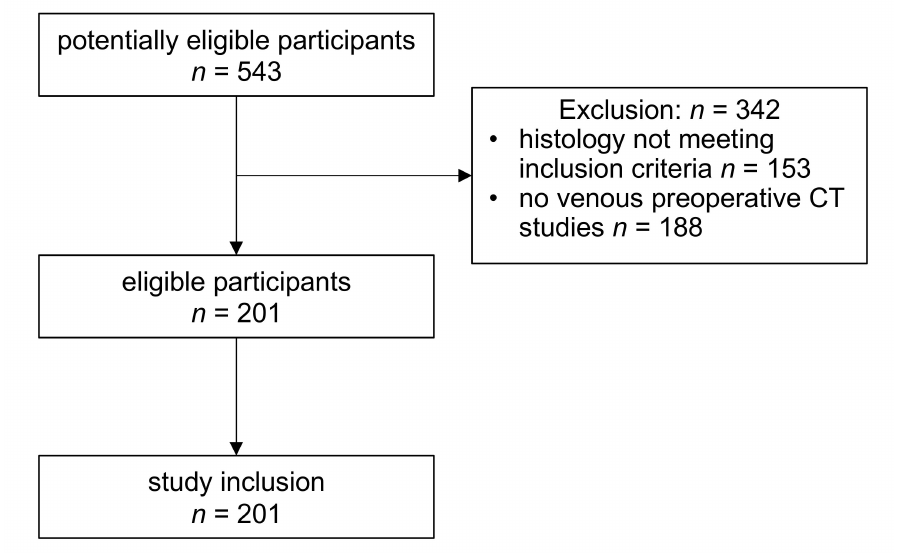
Figure 1. Flowchart of patient inclusion and exclusion.